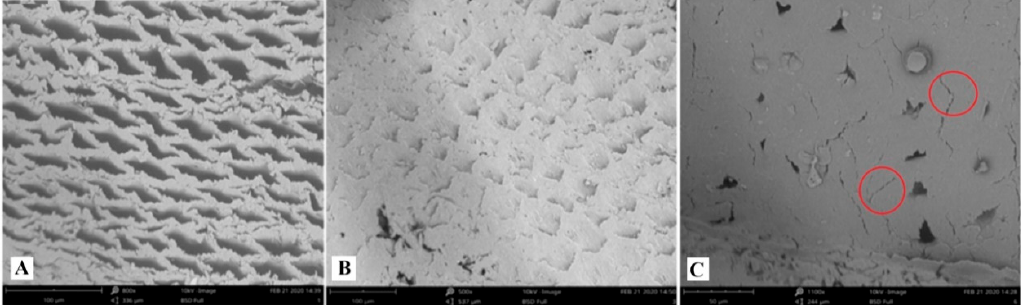
Figure 2. SEM images for the pine woods treated with 75% poly (furfuryl alcohol) ( A ), poly (styrene) ( B ) and poly (methyl methacrylate) ( C